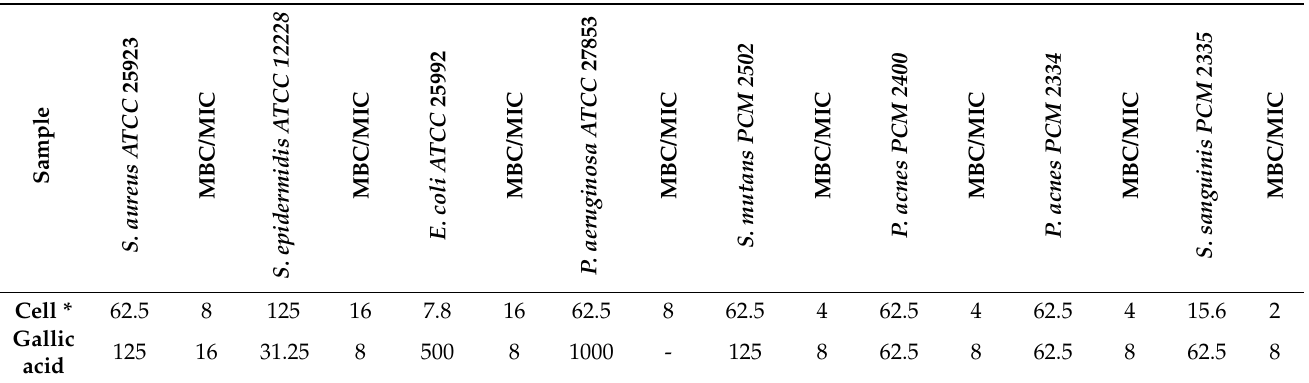
Table 4. The minimum inhibitory concentration (MIC, µ g/mL) and MBC/MIC ratio as an antibacte- rial activity of the studied C. smithii